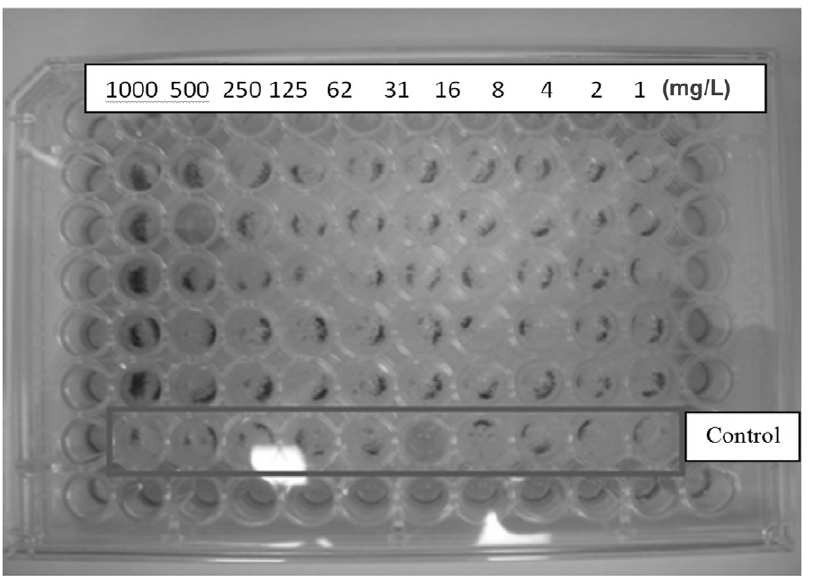
Figure 5. A photographic reproduction of a 96-well plate test after 120-hour incubation. The column of test cells having A. niger exposed to 1,000 mg/L PHF shows significantly higher growth than control or other PHF quantities.